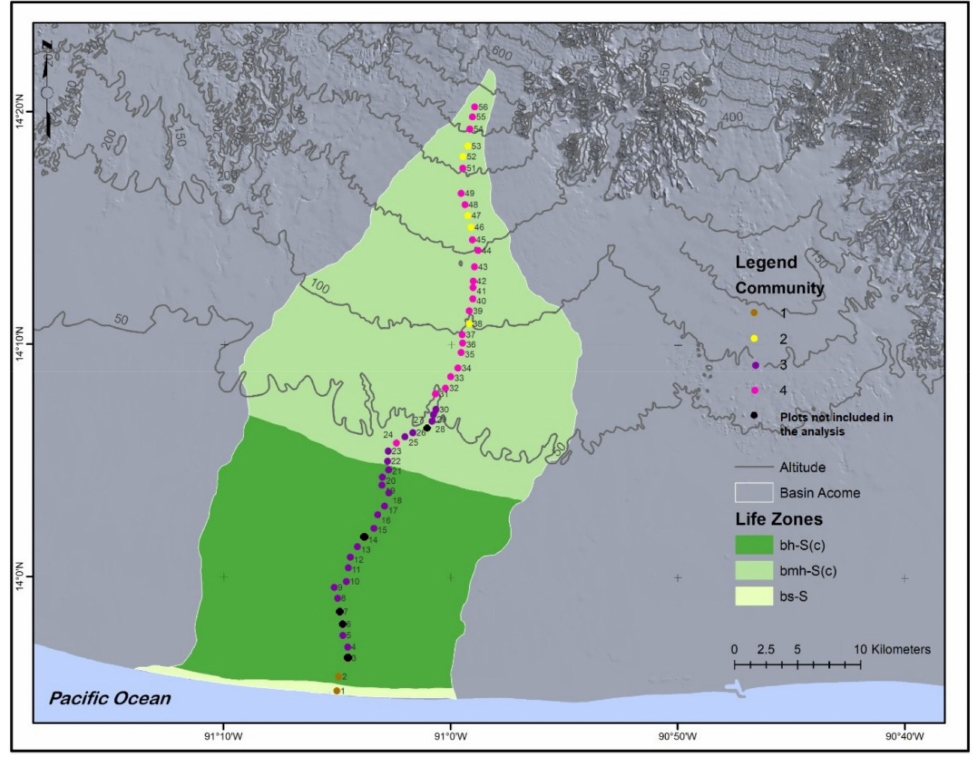
Figure 3. Distribution of tree communities on the banks of the Acom é River. The four major or dominant species in each riparian tree community and their impor- tance values are shown in Table